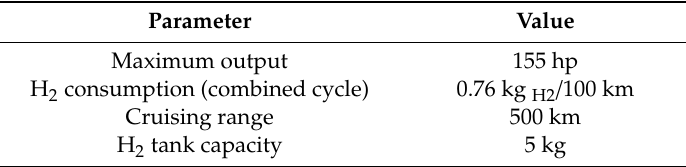
Table 3. The specifications for Toyota Mirai FCV [36].